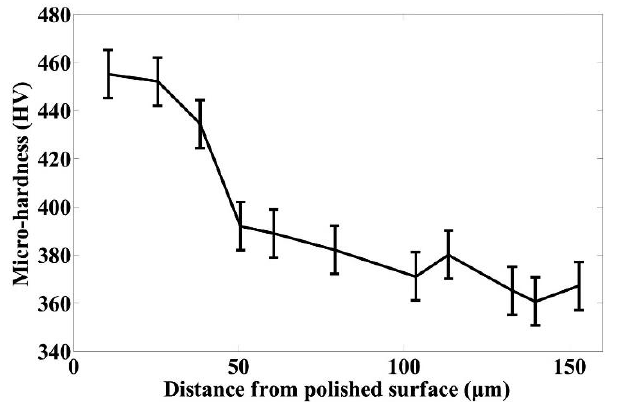
Figure 17. Evolution of hardness across the material [85]; with permission from Elsevier.